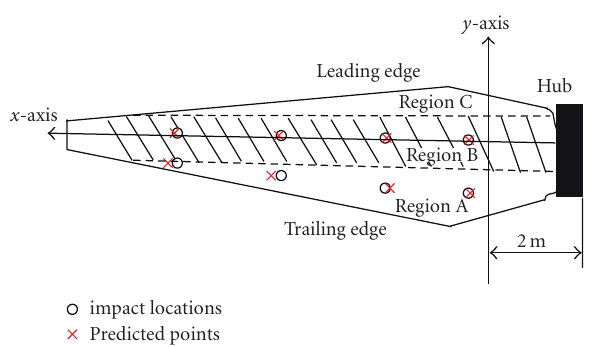
Figure 8: Comparison of the x -coordinates of the experimental impact and predicted locations for Regions A and B on the wind turbine